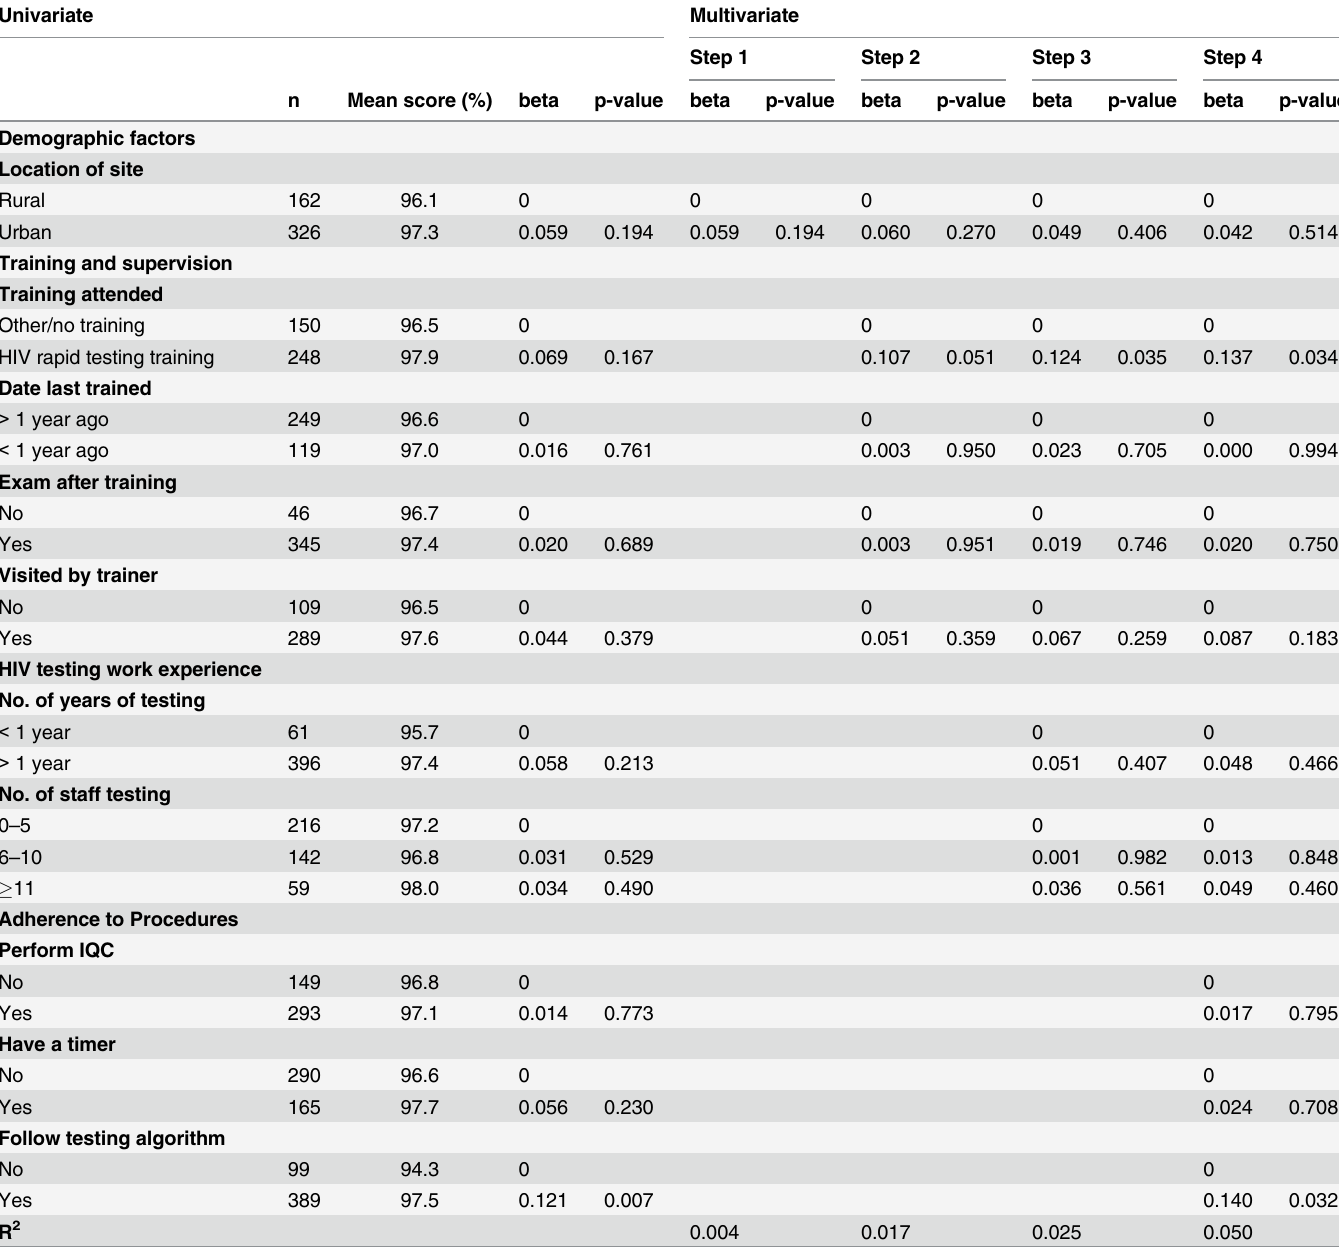
Table 5. Factors associated with accuracy in HIV rapid testing among all tester groups in PT2. Univariate